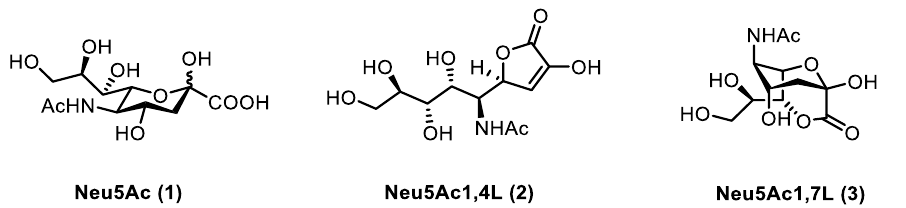
Figure 1. Neu5Ac and its lactone